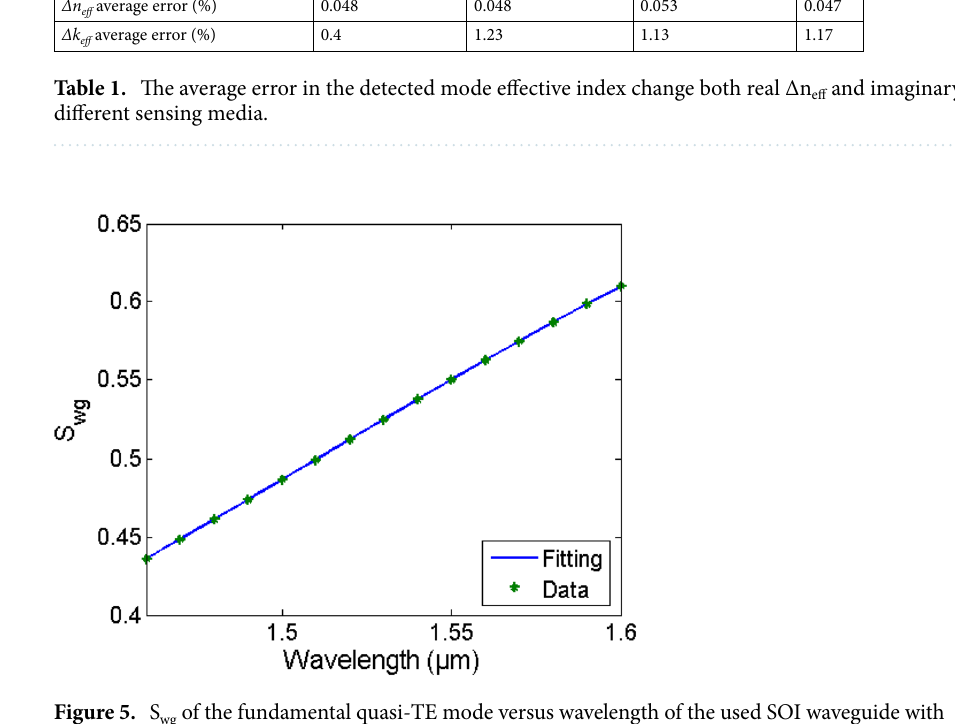
Figure 5. S wg of the fundamental quasi-TE mode versus wavelength of the used SOI waveguide with w = 320 nm and its 4th degree polynomial